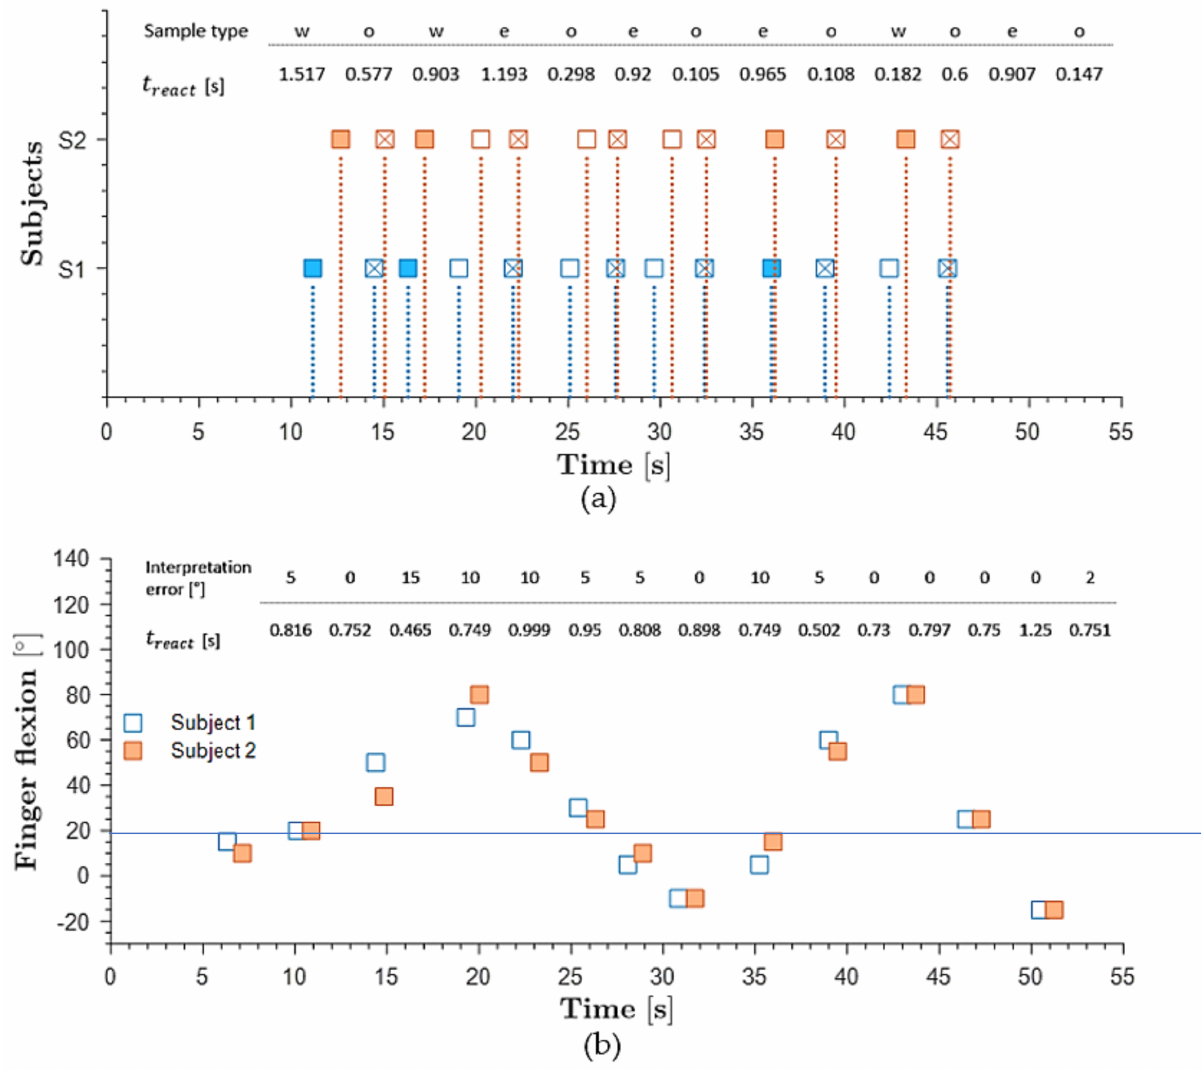
Figure 13. ( a ) Tactile feedback, with Subject 1 (S1) representing the master and Subject 2 (S2) playing the slave role in predicting the degree of index flexion of S1. w depicts weighted cube gripping; e depicts empty-cube gripping; and o depicts no gripping. ( b ) Proprioceptive feedback with finger flexion angle interpretation error of S2 including reaction